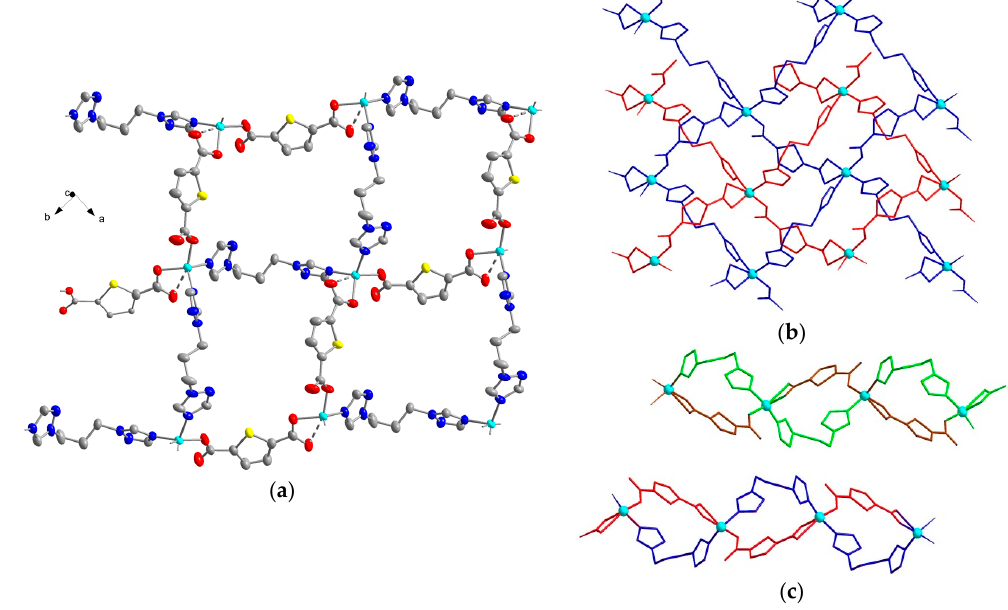
Figure 4. ( a ) Displacement ellipsoid plot of complex [Zn(tdc)(btrp)] ∙ nDMF ( 2 ) showing 50% probability ellipsoids. H atoms are not shown for clarity. Dashed lines indicate long-range Zn ∙∙∙ O interactions. ( b , c ). Relative arrangement of the layers of 1 colored green, red, blue, and brown.